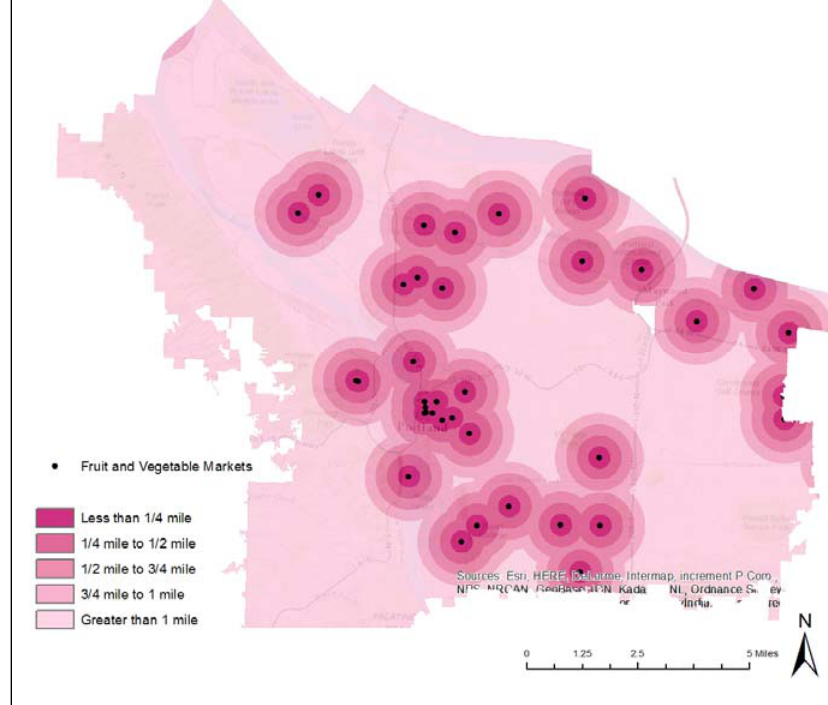
Figure 9. Proximity to Fruit and Vegetable